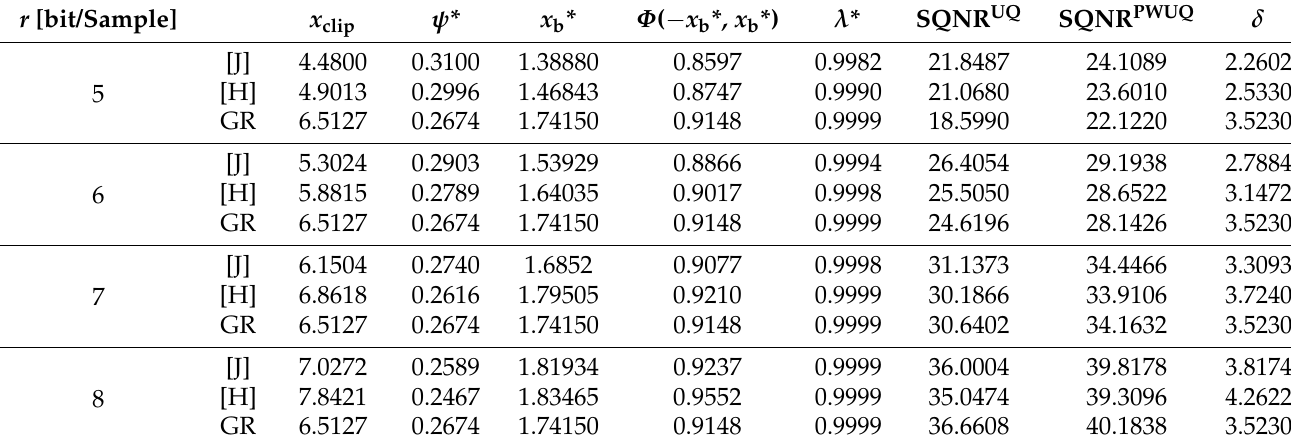
Table 1. Competitive presentation of key design parameters and performances of UQ and